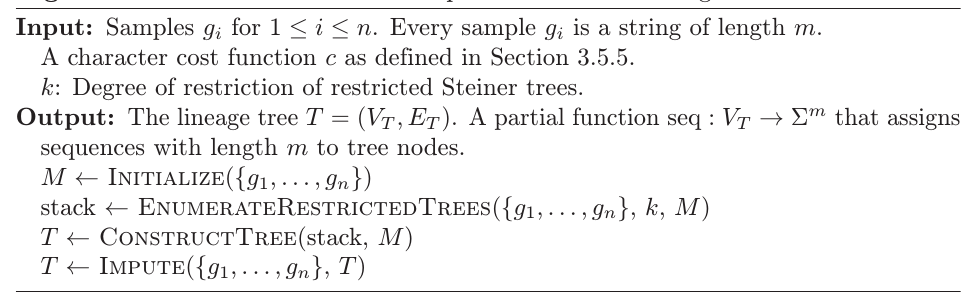
Algorithm 1 Pseudocode of the main part of the Scelestial algorithm